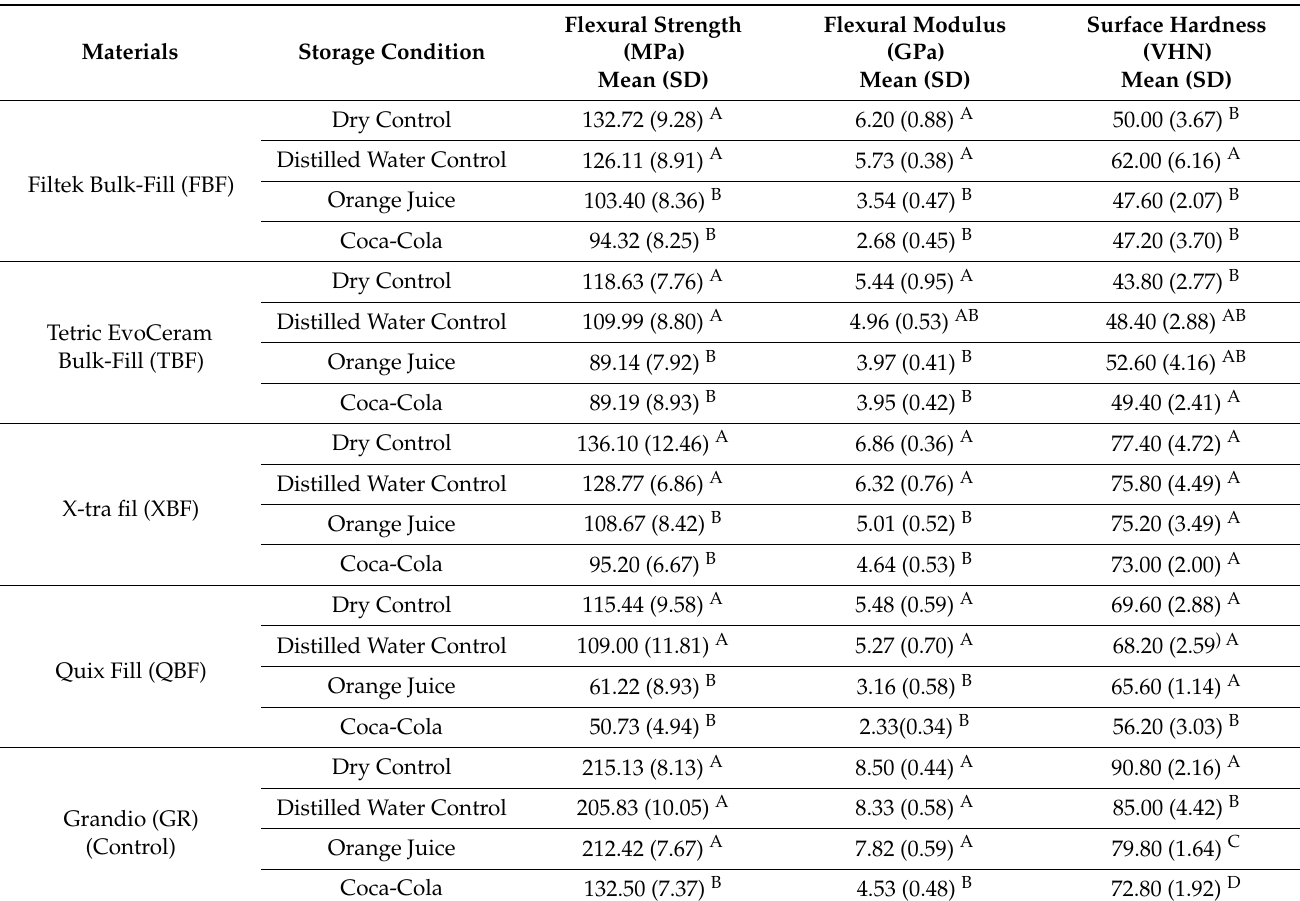
Table 2. The flexural strength, flexural modulus, and surface hardness of each RBC under different storage